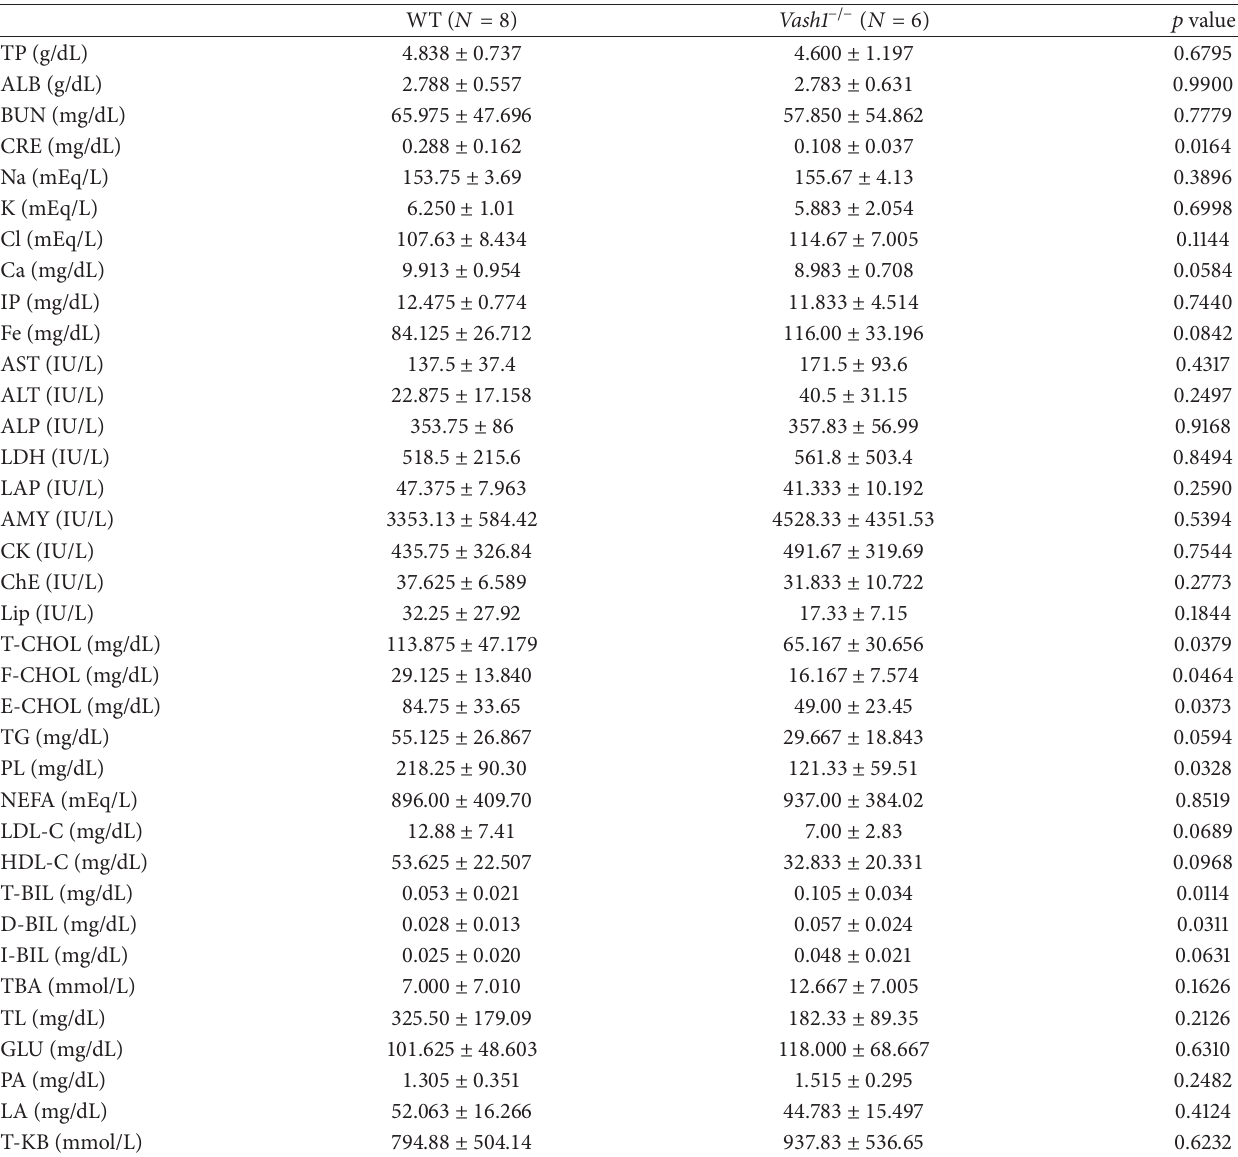
Table 1: Biochemical analysis of sera from WT and vash1 −/−